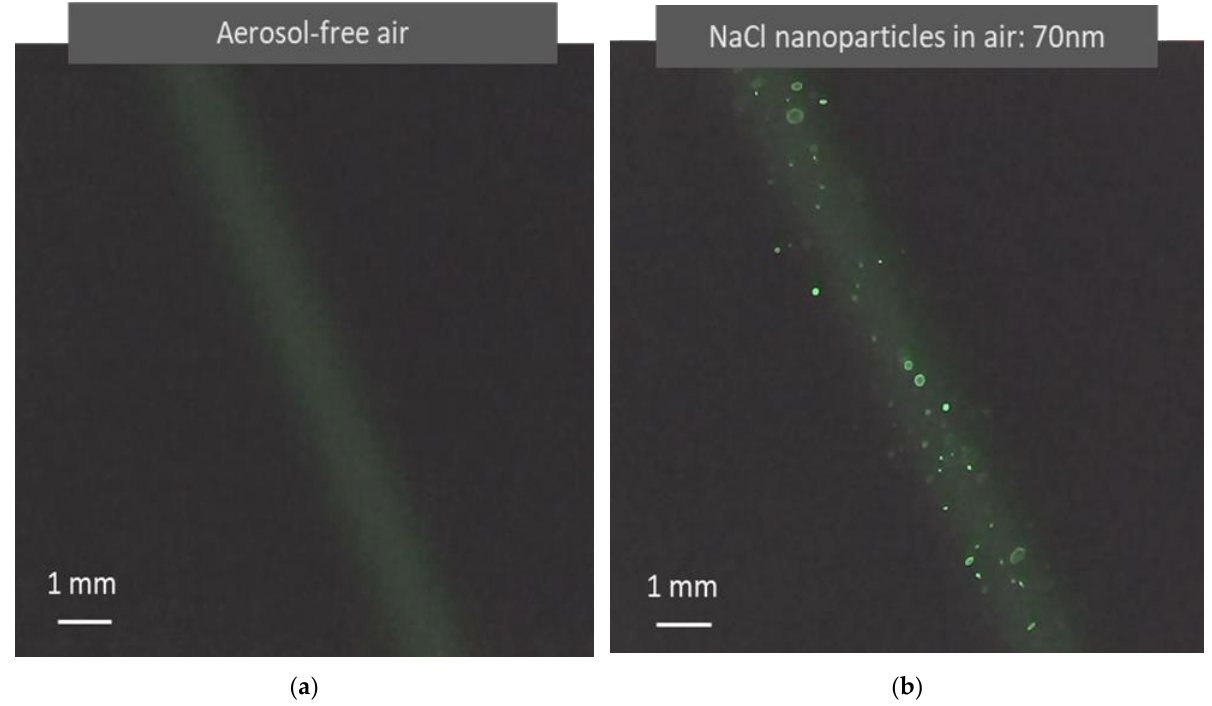
Figure 4. Images of light scattered from air molecules and airborne nanoparticles captured in light scattering detection videos. ( a ) Image formed when a green laser (λ = 532 nm) irradiates aerosol-free air. Unlike the Tyndall effect, the image results from the light scattered from molecules instead of colloidal particles. ( b ) Image formed when a green laser irradiates air containing monodisperse NaCl nanoparticles (70 nm). The nanoparticles become clearly visible as bright dots with air molecule light scattering as a background. The image size difference is caused by optical distortion from the optical system. These images are clearly present when the laser and the image sensor have sufficient power and sensitivity.